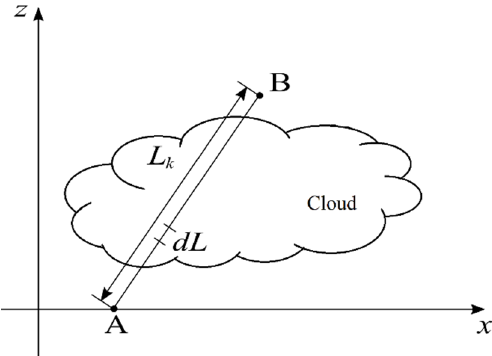
Figure 2. Calculation of the path-integrated attenuation, where the locations of the ground receiver and the satellite are marked by points A and B, respectively.